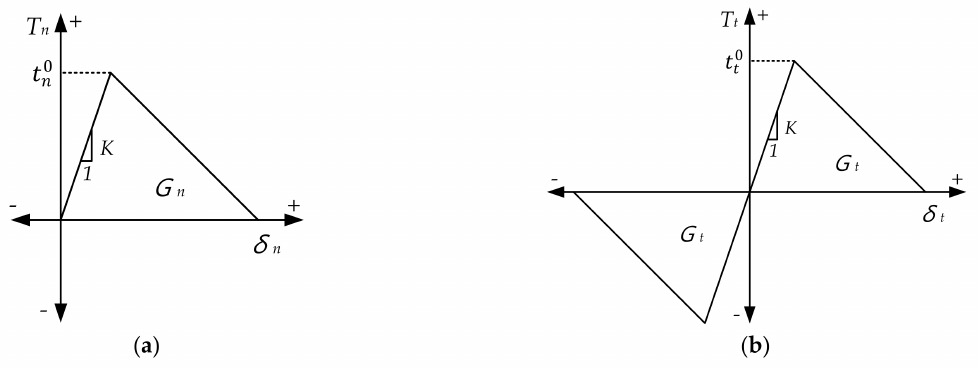
Figure 8. Traction-separation law: ( a ) normal mode; ( b ) shear